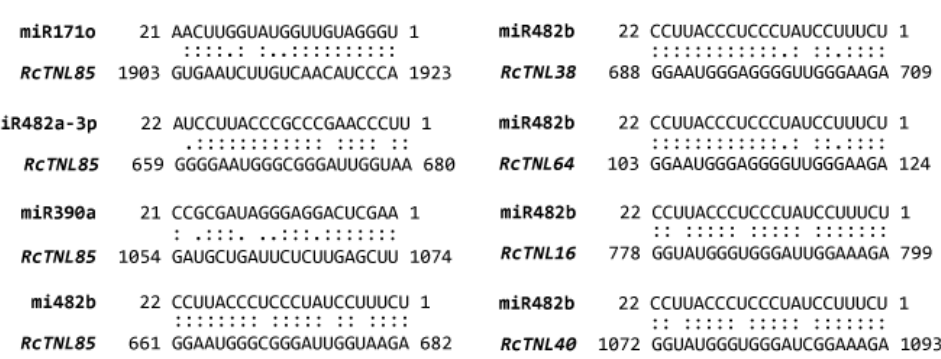
Table 1. Ka/Ks ratio of the duplicated RcTNL gene pairs in collinear blocks.